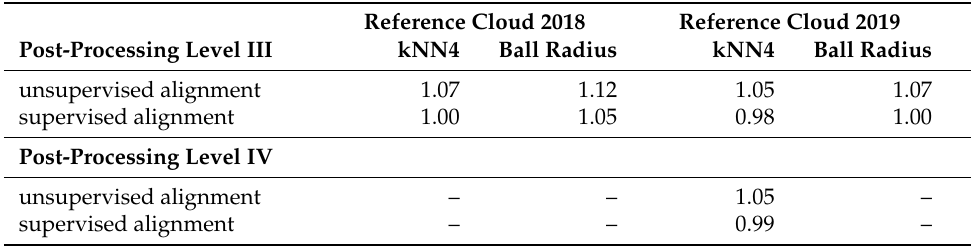
Table 4. Root Mean Square Error [m] of the alignment under post-processing level III (ICP alignment only) and post-processing level VI (AROSICS and ICP